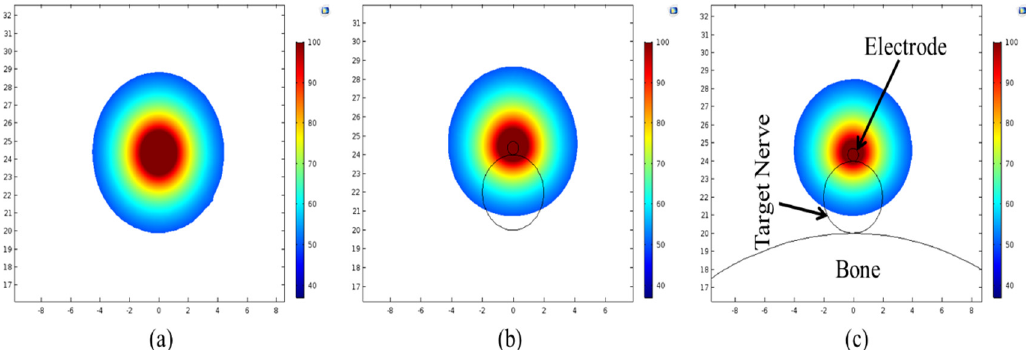
Figure 4. Temperature distribution (in °C) obtained after 60 s of continuous RF procedure in a plane along the electrode axis for: ( a ) homogeneous domain comprising of muscle tissue alone, ( b ) heterogeneous domain comprising of the target nerve embedded in the muscle tissue and ( c ) heterogeneous domain comprising of target bone, nerve and muscle tissues.